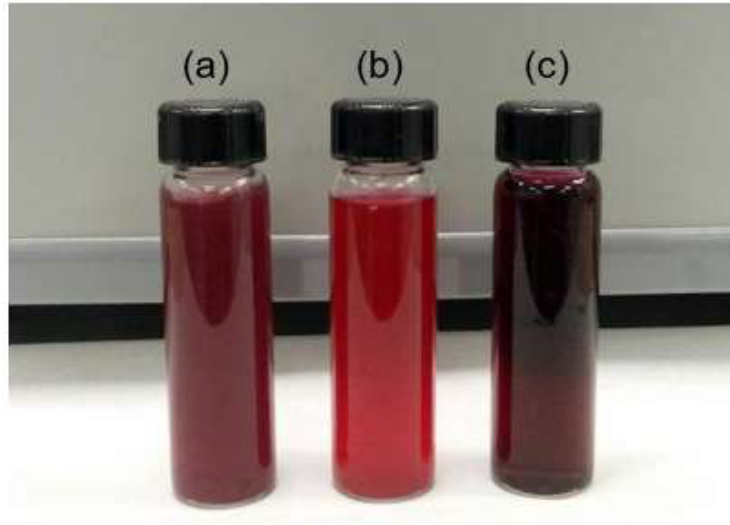
Figure 3. ( a ) black grape; ( b ) pomegranate, and ( c ) blueberry dye solutions.